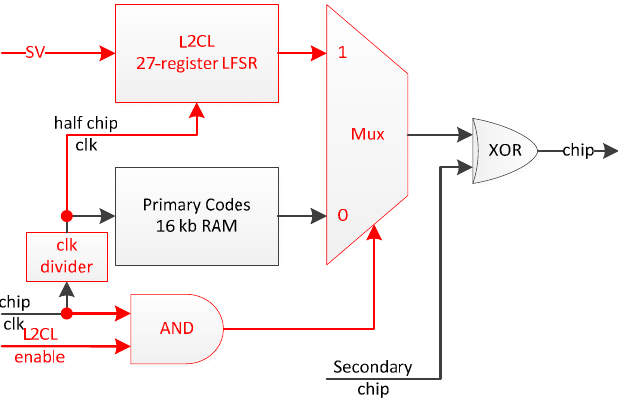
Figure 4. Spreading Codes Module (BPSK vs. TMBPSK Overhead).